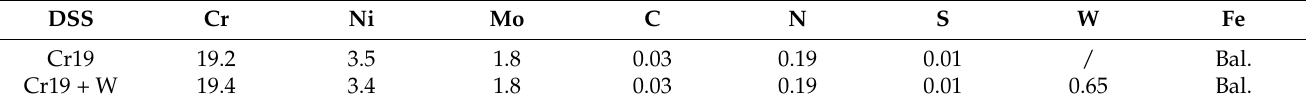
Table 1. Chemical compositions of the experimental Cr19 series DSS (wt.